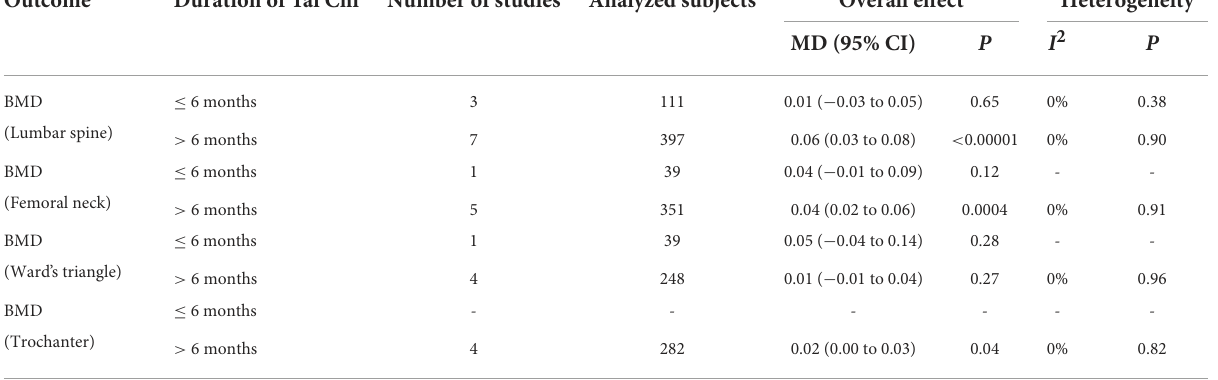
TABLE 3 Subgroup analysis according to the duration of Tai Chi compared with non-intervention. Outcome Duration of Tai Chi Number of studies Analyzed